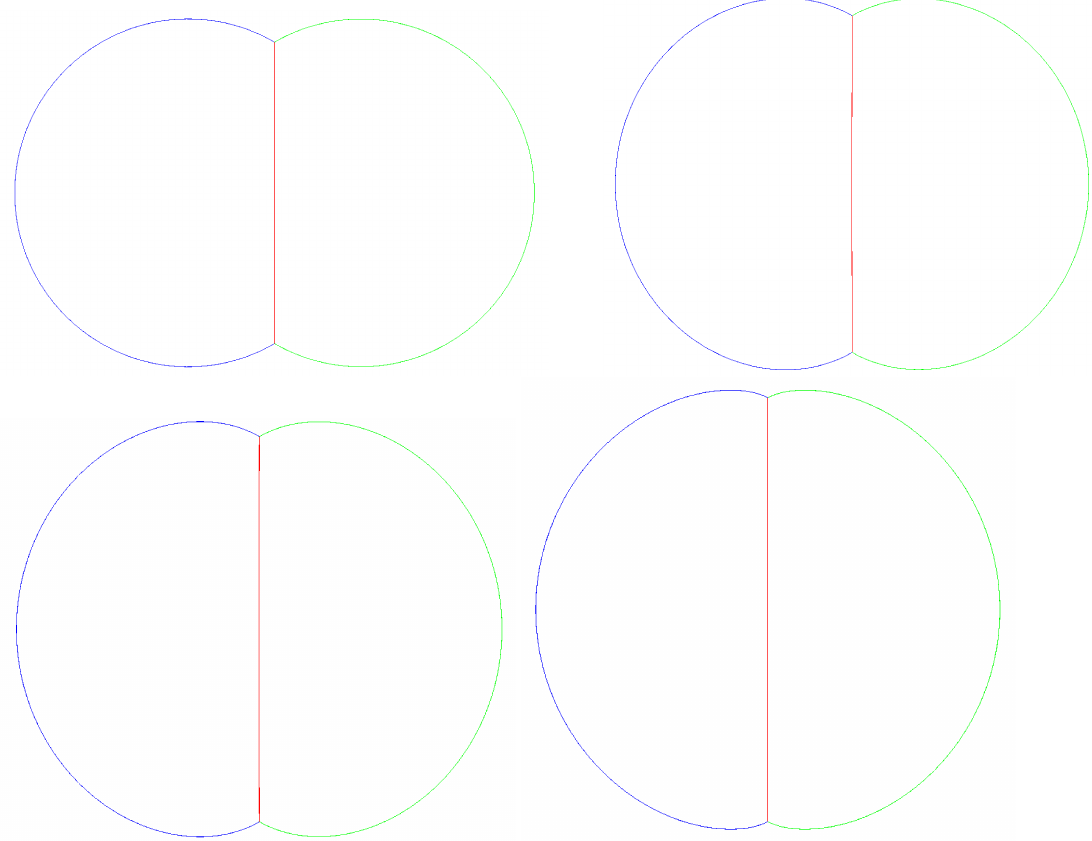
Figure 5: For increasing equal volumes (0.01, 0.1, 10 and 1000) the double bubble approaches a circle plus diameter. Computed with Brakke’s Surface